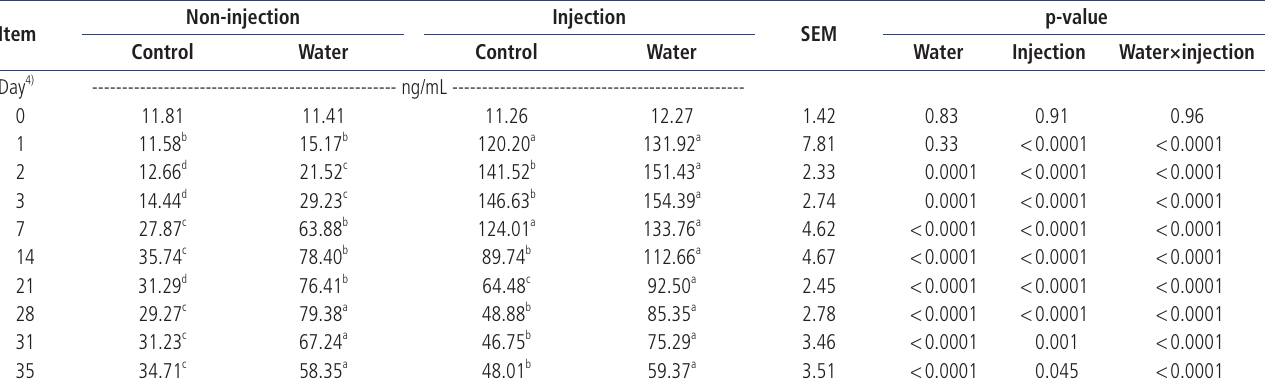
concentration changes of weaning pigs with vitamin D 3 Non-injection Injection